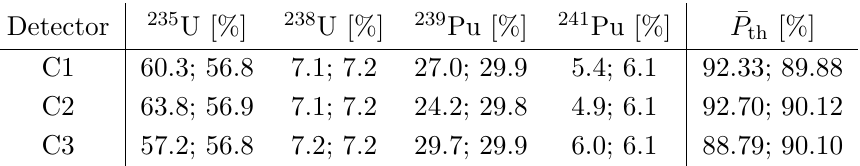
Table 1 . Average fission fractions of the most relevant isotopes in the reactor antineutrino spectrum and average reactor powers ¯ P th in terms of the reactor’s maximal thermal power of 3 . 9 GW for standard/extended data sets of Conus Run -1. The detectors C1-C3 used in the following analyses are assigned individual values due to their specific data collection